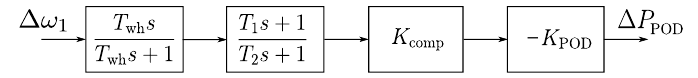
Figure 4. POD control block diagram whose output is used by VSC1 and